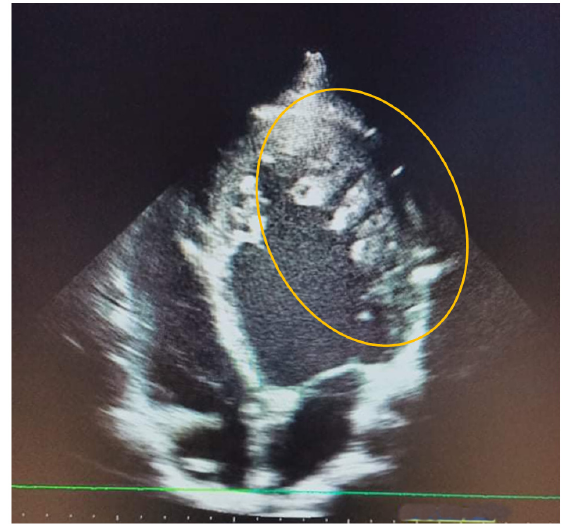
Figure 1. Transthoracic echocardiography aspect of the left free wall showing non compacted trabeculation